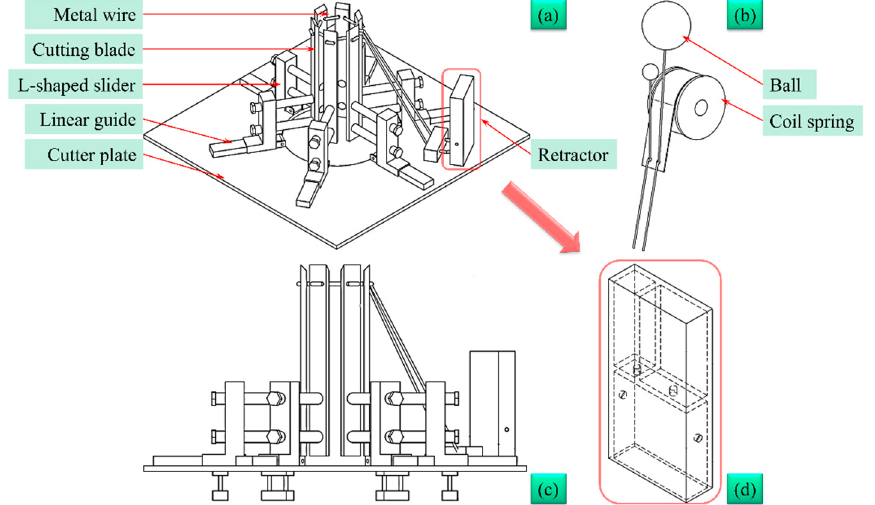
Figure 10. De-handing cutter based on wire-cutting. ( a ) Axonometric view, ( b ) Assembly schematic of the wire, coil spring and ball, ( c ) Front view, ( d ) Structure diagram of the casing of the retractor.